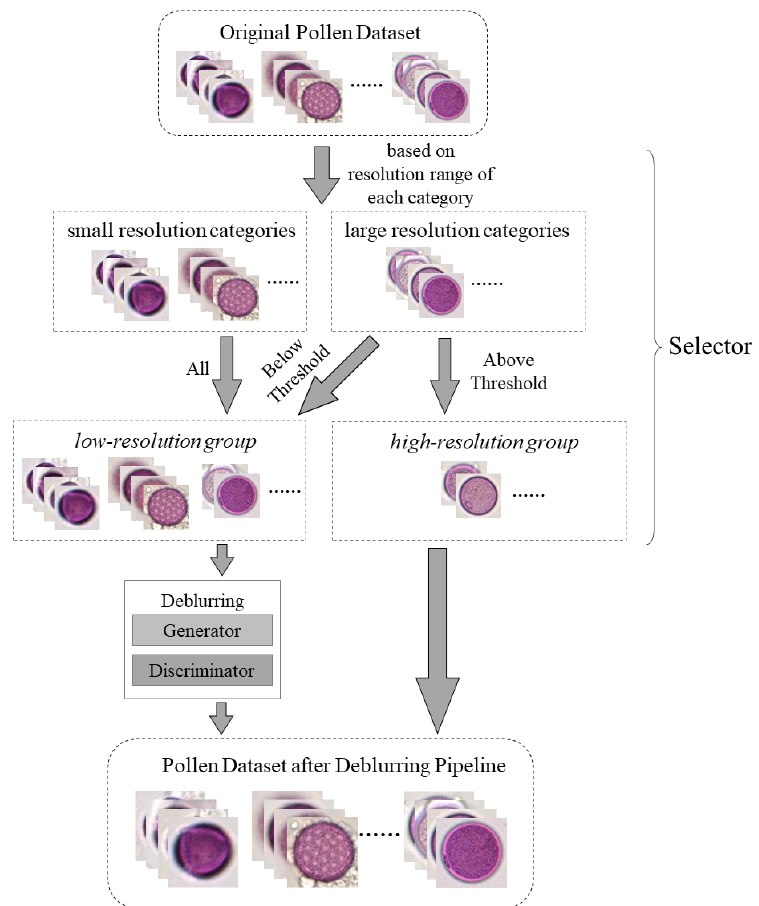
Figure 5. The overall pipeline of the deblurring